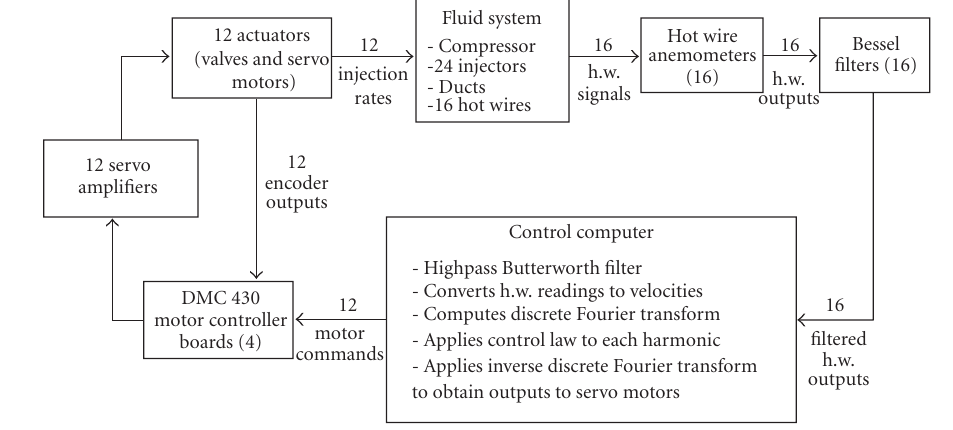
Figure 4: Closed-loop control feedback configuration.